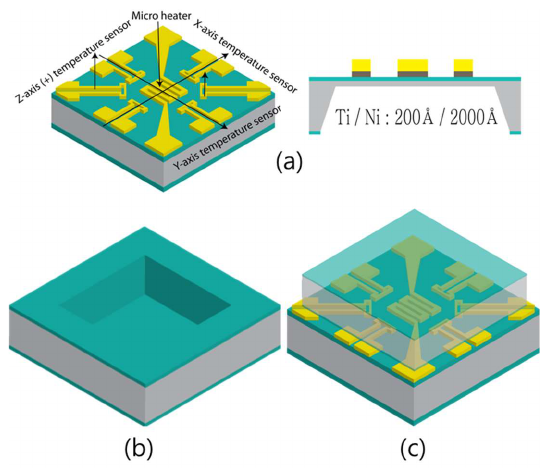
Figure 1. Proposed accelerometer with the ( a ) bottom and ( b ) top wafers and ( c ) bonded.